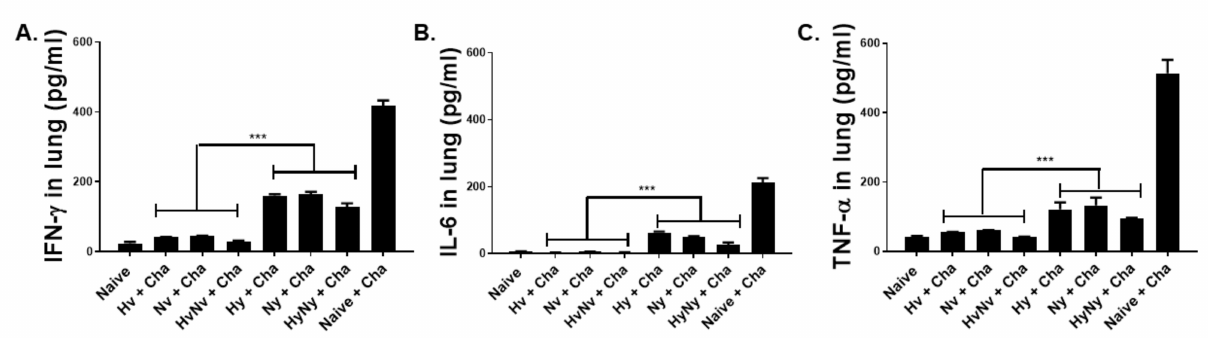
Figure 6. Pro-inflammatory responses in the lung after influenza B virus challenge infection. Levels of inflammatory cytokines IFN- γ ( A ), IL-6 ( B ), and TNF- α ( C ) were determined in the lung extracts at 4 dpi with B/Colorado/06/2017 virus. Naïve+Cha refers to those naïve mice who were challenge infected with a lethal dose of iInfluenza virus. Data are expressed as mean ± SD with asterisks denoting statistical significance between groups (*** p <